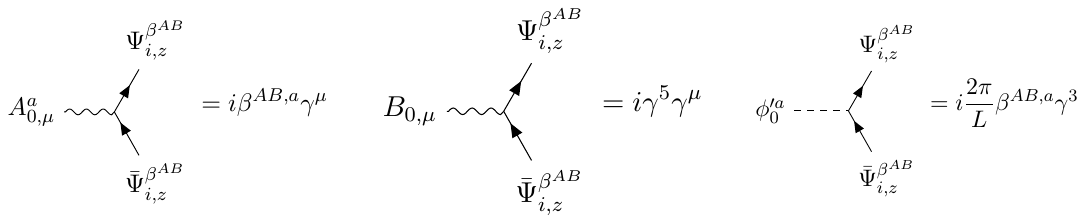
Figure 2. The interaction vertices between the non-Cartan adjoint fermions and the light gauge and global background fields.